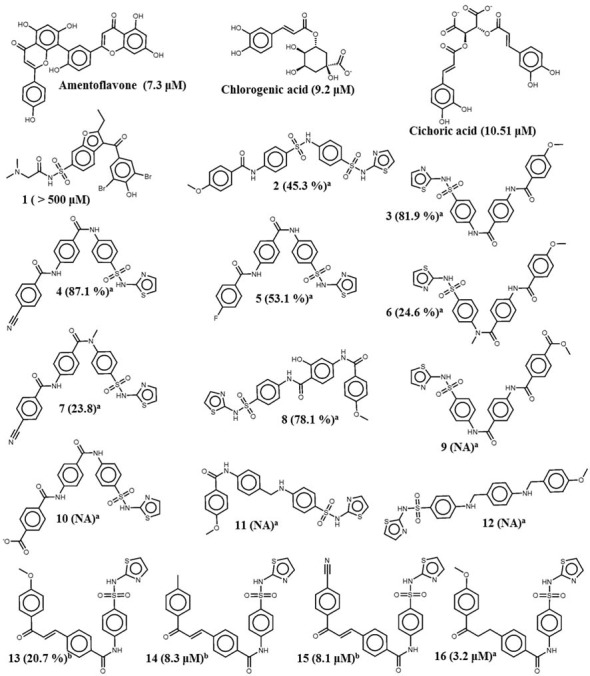
19 test molecules that are used for the validation of the pharmacophore model. [32,33,48] Values in bracket indicate activity of the molecules either in IC50 values or in % inhibition.a The percentage inhibition was measured under the concentration of 100 μM. b The percentage inhibition was measured under the concentration of 10 μM.